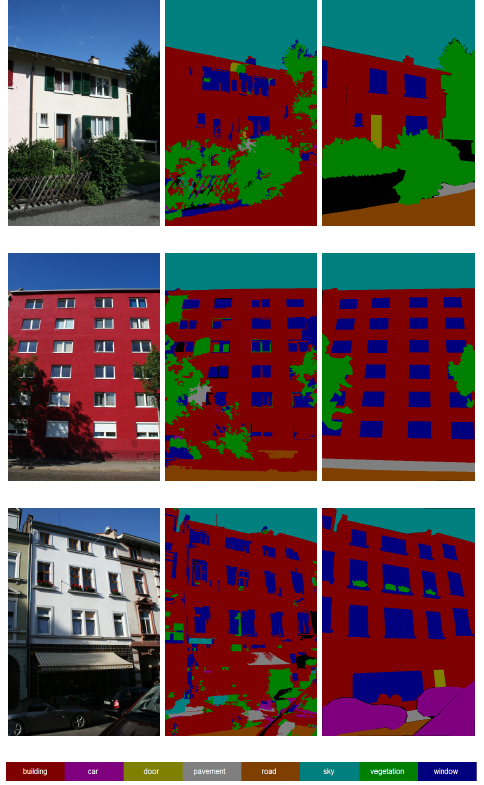
Figure 5: Qualitative classification results of a RDF classifier with the mean shift on the testing images from the eTRIMS dataset. ( Left : test image, middle : result, right : ground truth.)